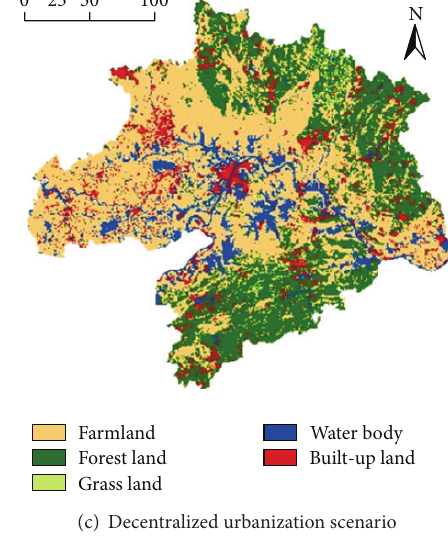
Figure 3: Spatial Pattern of Land Use under Different Urbanization Scenarios in Wuhan